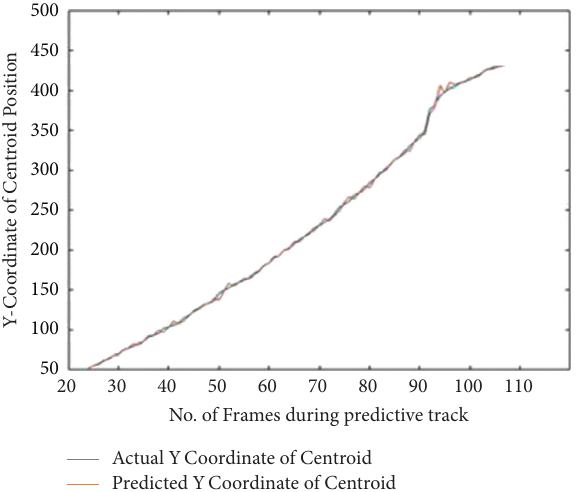
Figure 2: The difference between the predicted Y -coordinate and the actual Y -coordinate of the vehicles’ centroid during predictive track.